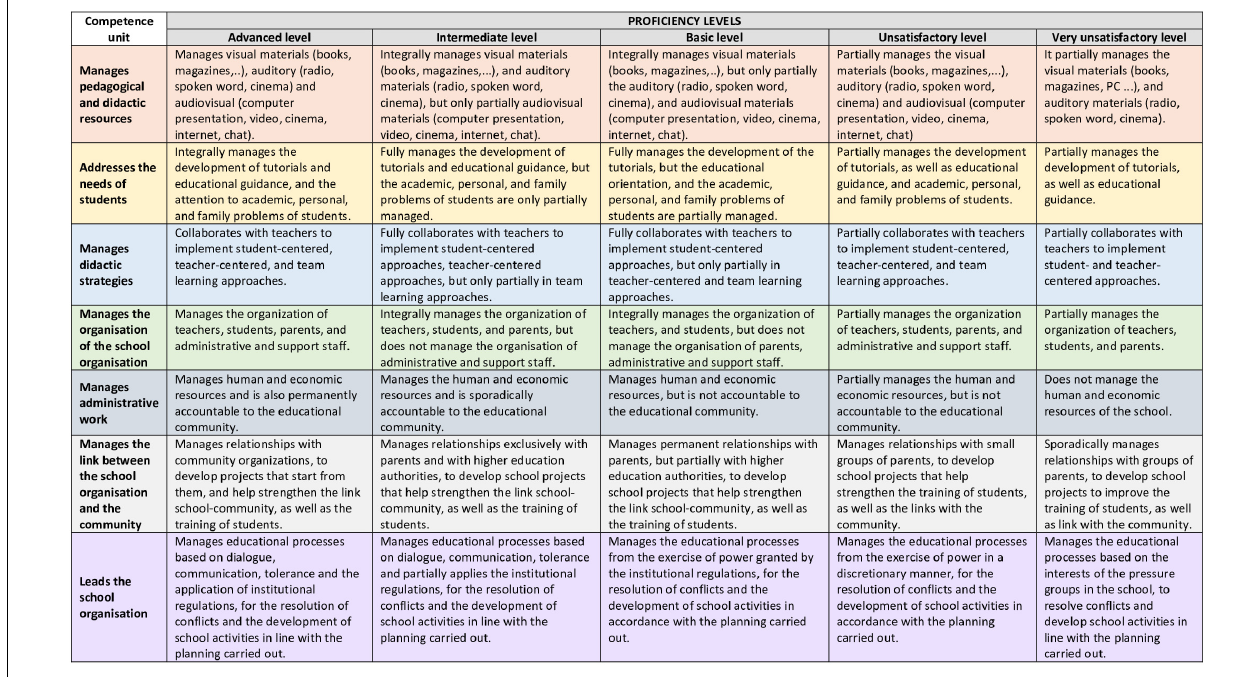
Frontiers in Psychology |